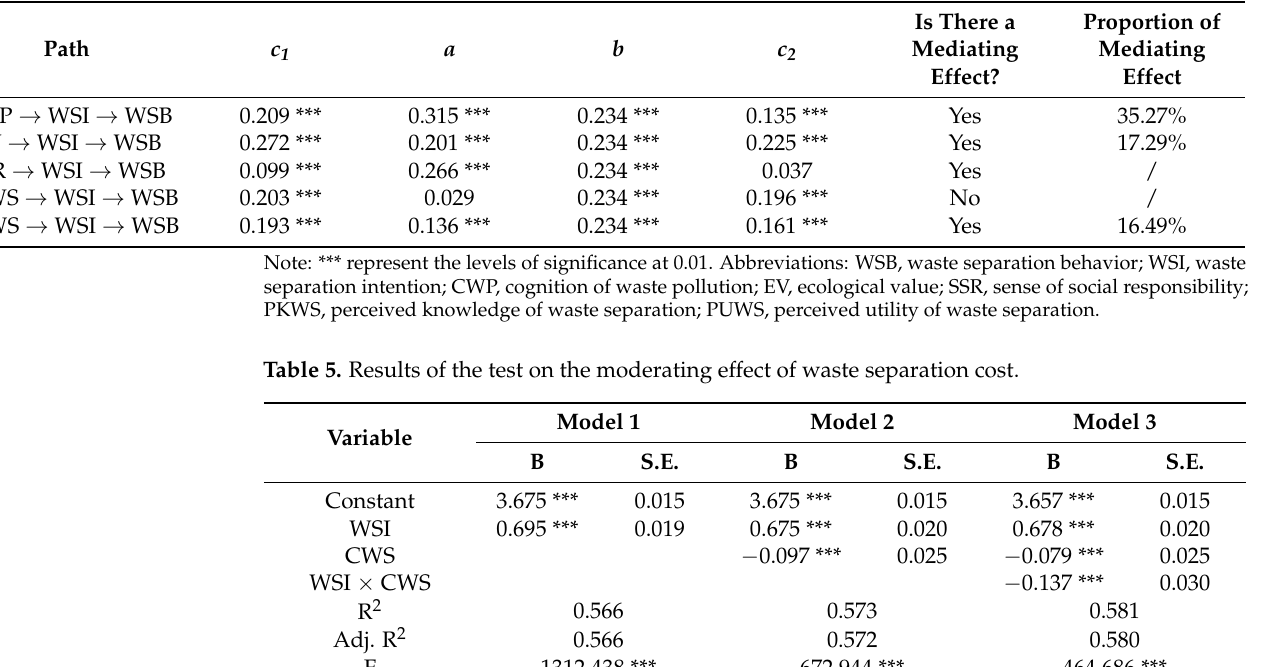
Table 4. Results of the test on the mediating effect of waste separation intention.